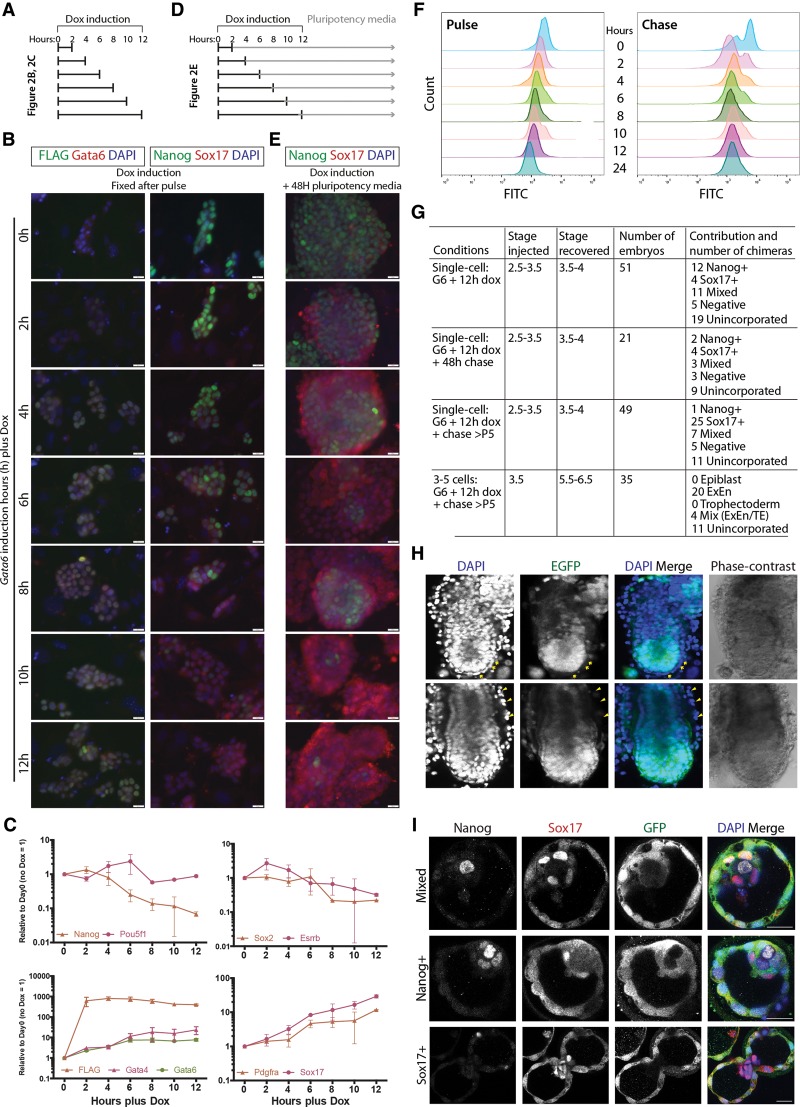
A short pulse of Gata6 induction initiates iXEN cell reprograming (A) Time line of induction experiments. Cells were pulsed for incremental 2-h time periods and, at the end of each period, were analyzed by either immunohistochemistry, qRT–PCR, or flow cytometry. (B) Immunofluorescence analysis for Flag (green), Gata6 (red), and DAPI (blue) merge or with Nanog (green), Sox17 (red), and DAPI (blue) merge in Gata6-induced cells immediately after doxycycline treatment for the defined periods. Bars, 20 μm. (C) qRT–PCR analysis for exogenous Flag-tagged Gata6 expression and selected pluripotency and endoderm transcripts in Gata6-overexpressing mES cells between 0 and 12 h of doxycycline induction. Relative expression is reflected as fold difference over uninduced mES cells normalized to Gapdh. Data are mean ± SEM of two biological replicates. (D) Time line of induction pulse-chase experiments. Cells were pulsed for incremental 2-h time periods and, at the end of each period, were switched into pluripotency medium for 48 h and then analyzed by immunohistochemistry or flow cytometry or switched into pluripotency medium to derive stable iXEN cells. (E) Immunofluorescence analysis for Nanog (green), Sox17 (red), and DAPI (blue) merge in Gata6-induced cells treated with doxycycline treatment for the defined periods and then switched into pluripotency medium for 48 h. Bars, 20 μm. (F) Flow cytometry analysis of Nanog expression at the defined time points in the pulse and pulse-chase cells. (G–I) Chimera contribution of unlabeled Gata6-induced cells injected into B5/EGFP embryos that constitutively express EGFP. (G) Summary of the number of cells injected, the stage of injection and dissection, and chimera contribution. (H) Embryonic day 5.5 (E5.5)–E6.5 post-implantation embryos with unlabeled iXEN cell contribution to the visceral (arrow) or parietal (arrowhead) endoderm. Representative images of chimeras with phase-contrast, DAPI (blue) nuclear staining, and embryo EGFP expression. (I) E3.5–E4 chimera blastocysts immunofluorescently analyzed for the expression of the PrE marker Sox17 (red), the epiblast marker Nanog (white), EGFP (green), and DAPI (blue) merge. Bars, 100 μm.